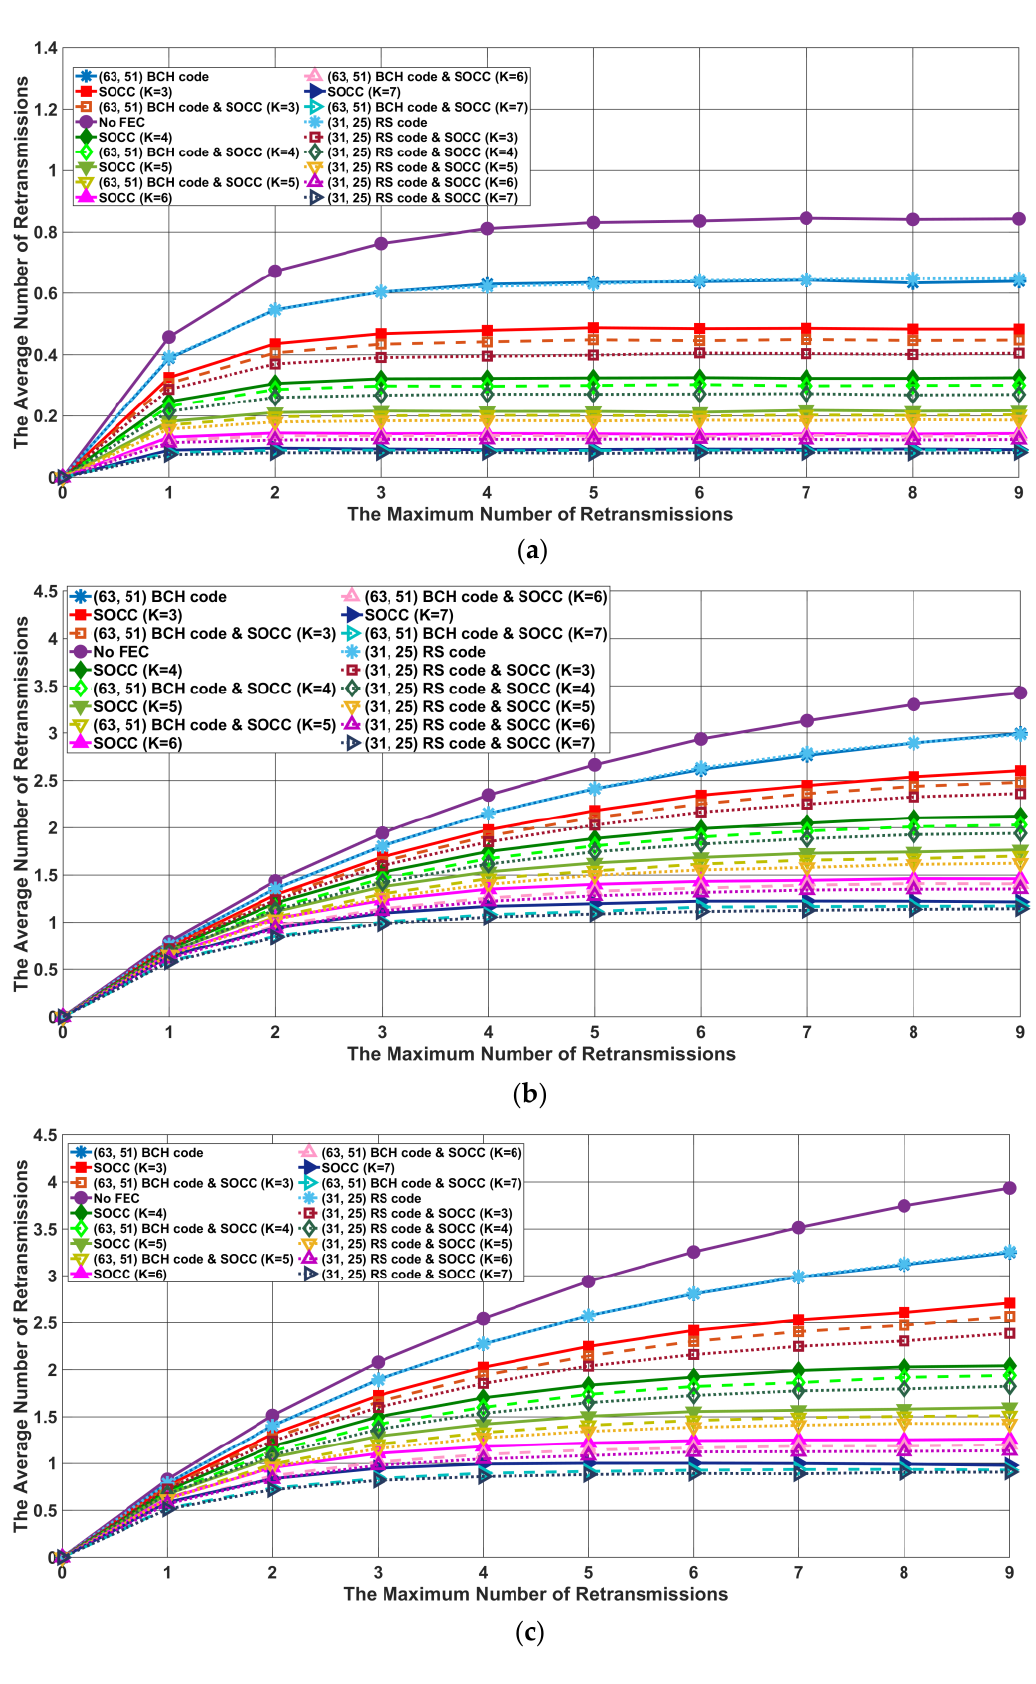
Figure 8. Energy efficiency as a function of the maximum number of retransmissions in the case of the single pulse option for each link type: ( a ) LD, ( b ) MD, and ( c ) HD.